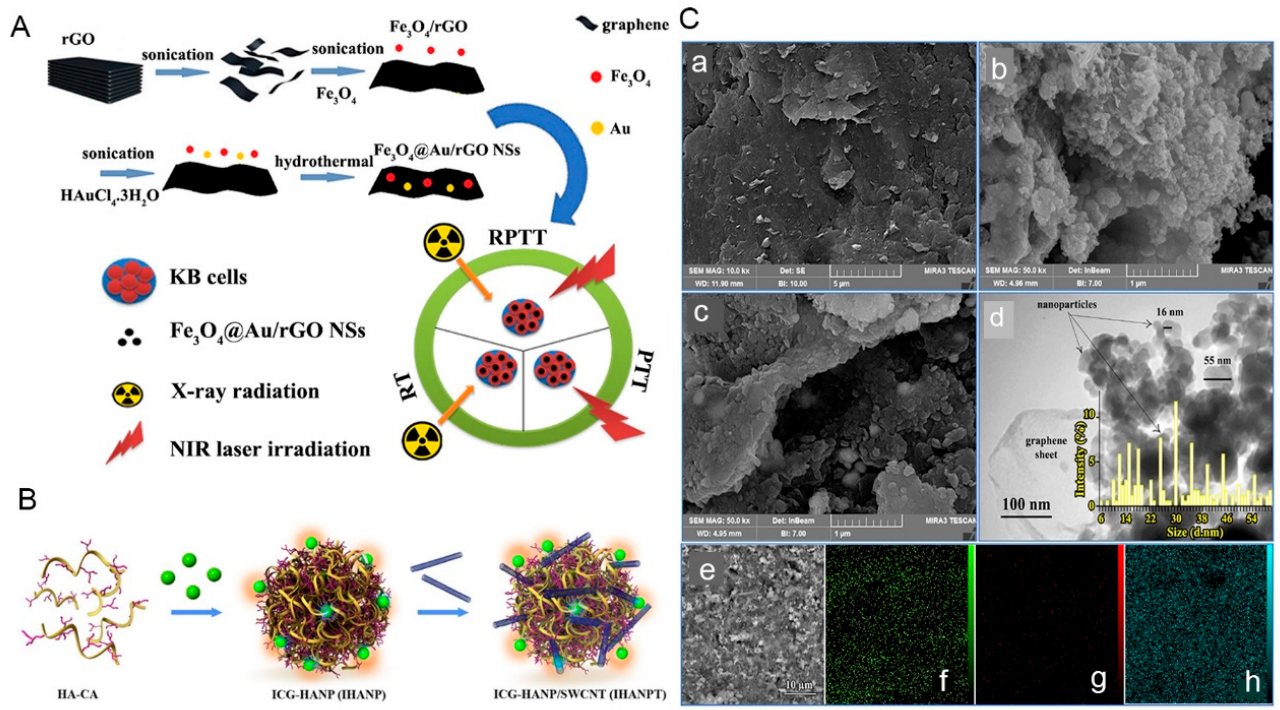
Figure 3. Schematic illustrations of several carbon-based nanomaterials. ( A ) Schematic illustration of the synthesis process and applications of Fe 3 O 4 @Au/reduced graphene oxide nanostructures (Fe 3 O 4 @Au/rGO NSs). ( B ) Schematic illustration of the synthesis process of Indocyanine Green (ICG)-coupled threadlike nanoparticles (IHANPT). ( C ) Field emission scanning electron microscope (FE-SEM) images of ( a ) GO and Fe 3 O 4 @Au/rGO NSs with ( b ) 10 and ( c ) 40 wt%, and ( d ) TEM image and particle size distribution of Fe 3 O 4 @Au/rGO NSs with 10 wt% rGO content. ( e ) Scanning electron microscope (SEM) image of Fe 3 O 4 @Au/rGO NSs with 40 wt% and corresponding EDS elemental mapping images of ( f ) C, ( g ) Au, and ( h ) Fe acquired at the same region. Adapted with permission from [81,82]. Copyright 2022, Elsevier and American Chemical Society, respectively. EDS: energy dispersive spectroscopy; RPTT: radio-photothermal therapy. Table 2. A summary of carbon-based nanomaterials and metal compounds for PTT in OSCC.